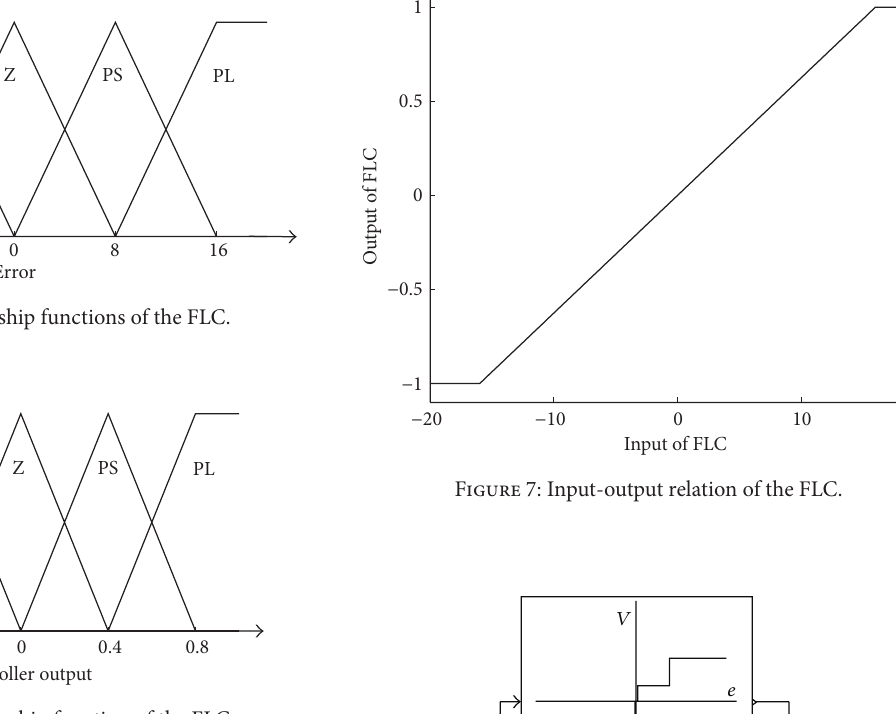
Figure 6: Output membership function of the FLC.